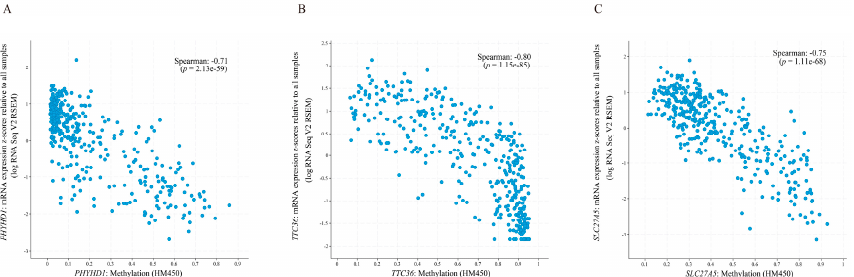
Figure 5. Correlations of methylation levels of ( A ) PHYHD1, ( B ) TTC36, and ( C ) SLC27A5 with corresponding mRNA levels (analyzed by the cBioPortal platform). The y axis shows the mRNA expression z-scores of the target gene relative to all samples. The x axis is the methylation level of the target gene (obtained from the HumanMethylation450 BeadChip platform). A Spearman correlation coefficient < − 0.7 was considered to indicate a strong negative correlation. A p -value < 0.05 was considered statistically significant. Abbreviations: HM450, HumanMethylation450 BeadChip; RSEM, RNA-Seq by Expectation-Maximization.